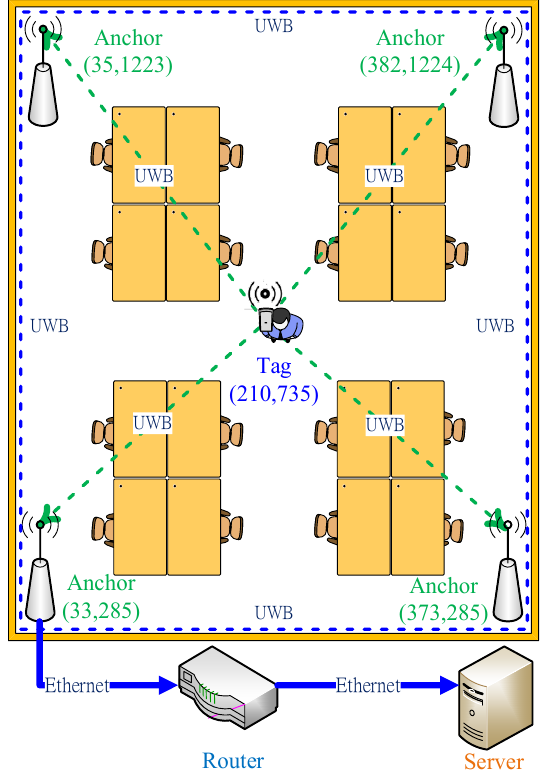
Figure 3. The system architecture of ultra-wideband (UWB) indoor positioning systems.